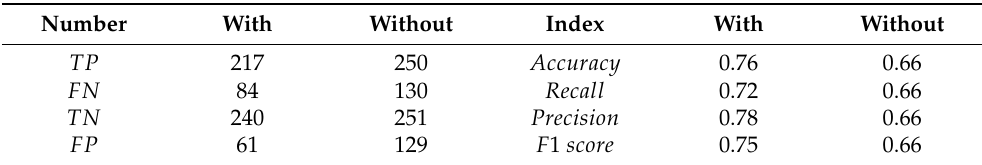
Figure 13. The susceptibility map of Bijie and model performance after removing the data prepro- cessing of the fishnet gird. ( a ) Distribution of training and test sets without fishnet grid processing. ( b ) ROC curves and AUC values without fishnet gird processing. ( c ) The susceptibility map without fishnet grid processing. ( d ) Comparison of models’ simulated effects before and after processing (the percentage of area in the very high level without preprocessing was 0.25%, and the percentage of hazard points located in the very low level without preprocessing was 0.39%). Table 5. Comparison of confusion matrices and accuracy indexes of test set with or without prepro- cessing